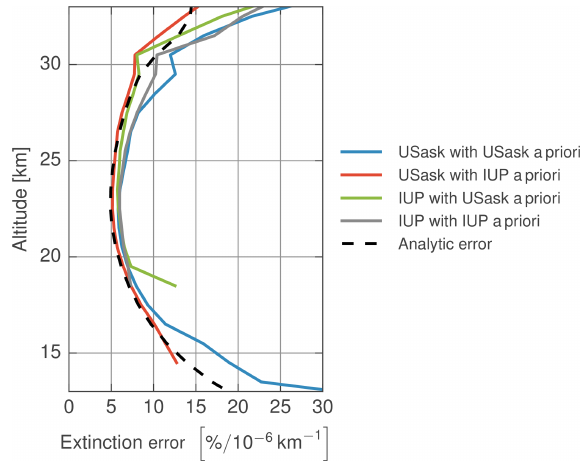
Figure 5. Percent error in the OSIRIS data retrievals as a function of altitude relative to an extinction error of 10 − 6 km − 1 at 35km. Solid lines show values computed from the best fit line from the simula- tion studies shown in Fig. 4. Dashed line shows the error expected from the linear error analysis of Eq.